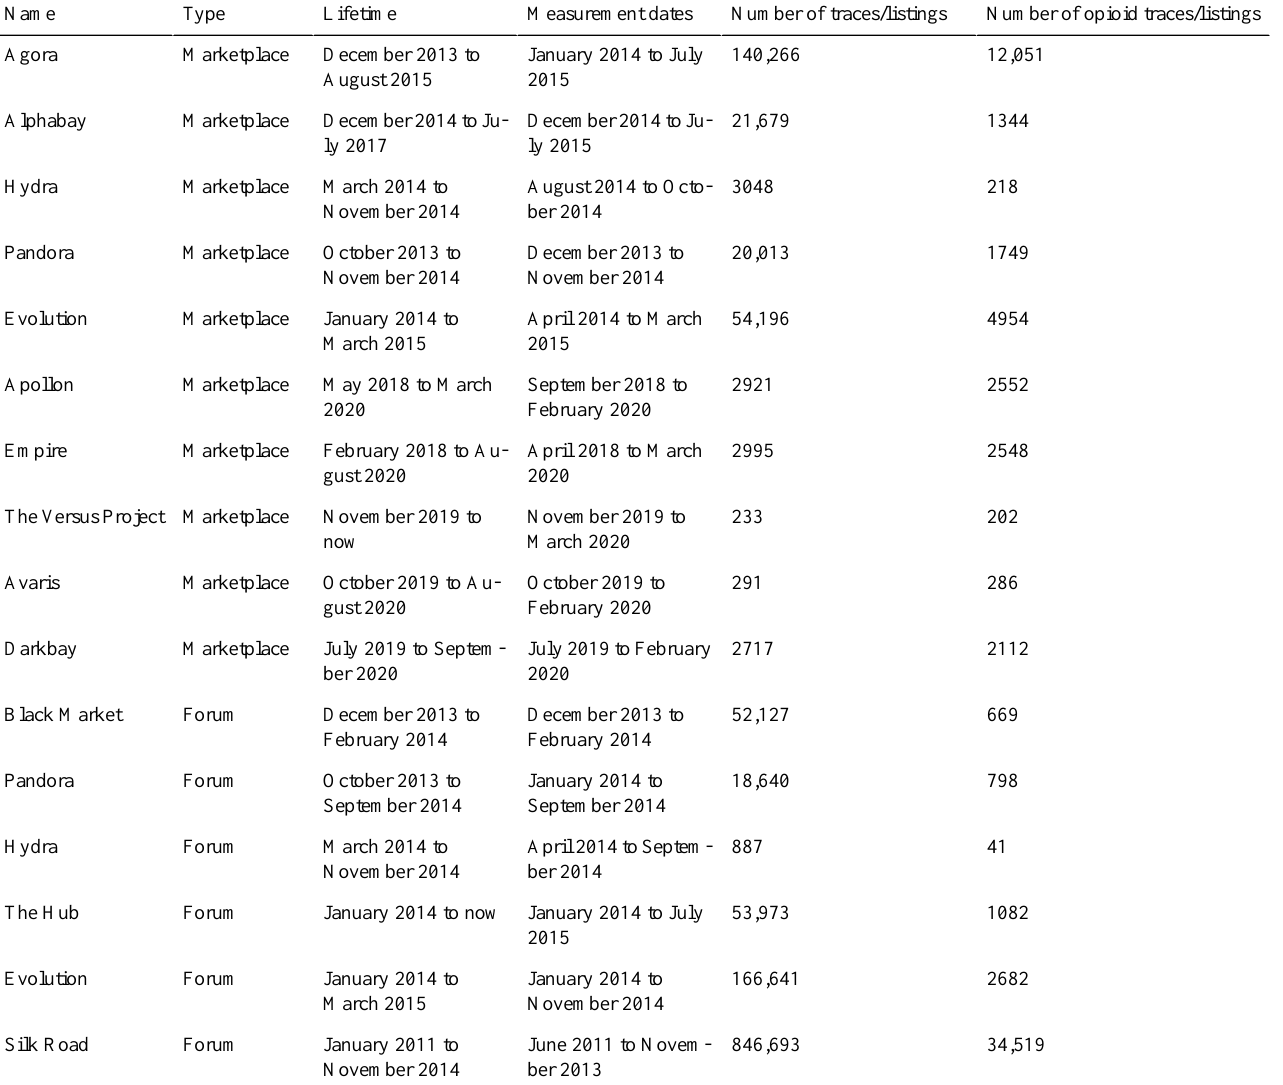
Table 1. Data set summary of marketplaces and forums that were collected for this